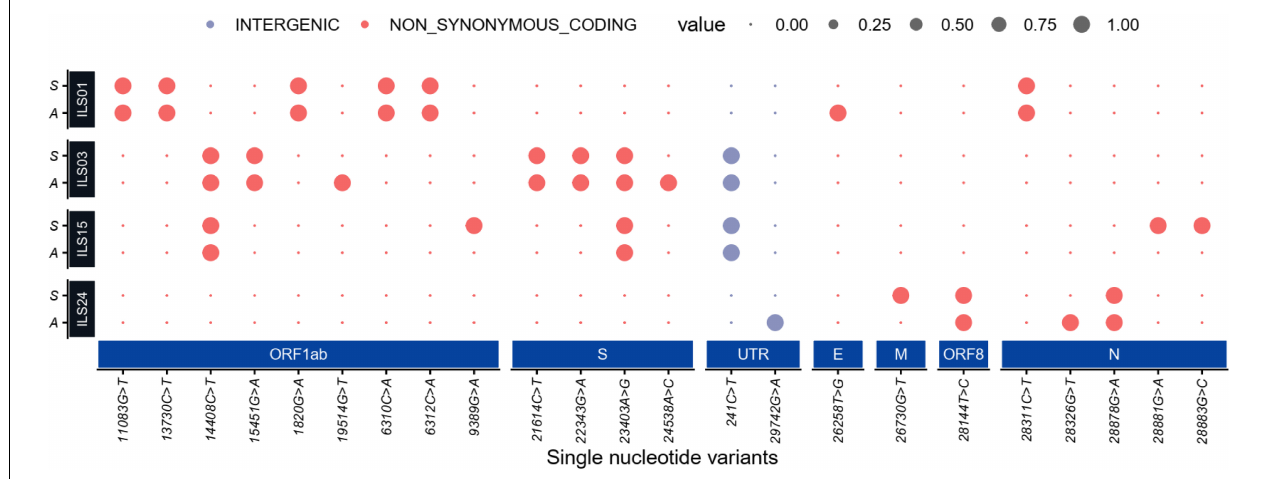
FIGURE 6 | Mutation plot of the isolates and source swab samples: Dot plot representing high-quality single-nucleotide non-synonymous and intergenic variants (SNV) present in the initial viral RNA isolated from patients’ swab samples (denoted as S ) and viral RNA from culture adapted isolates (denoted as A ). The large dot represents the presence of an SNV in the represented sample colored by their functional annotations (gray for intergenic and red for non-synonymous SNVs). The synonymous mutation is not shown in the dot plot.